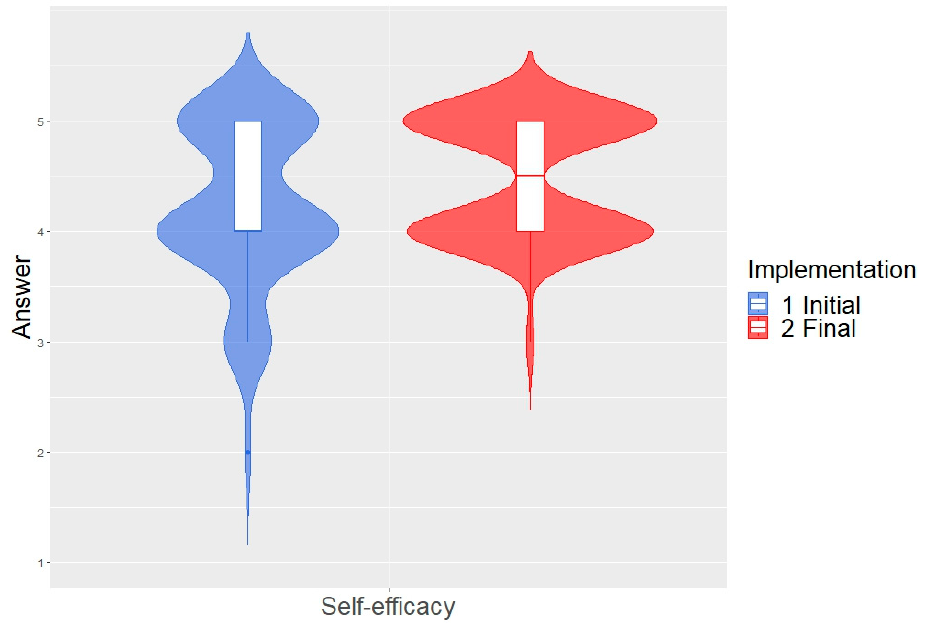
Figure 4. Entrepreneurial self ‐ efficacy competency results (Initial–Final).